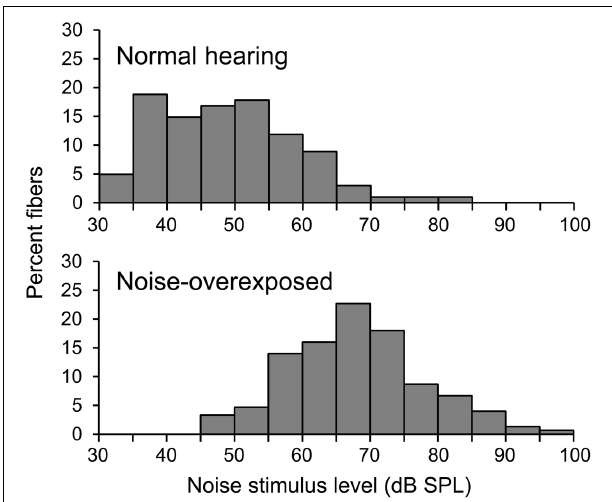
FIGURE 2 | Noise stimulus level. Histograms showing the distribution of noise stimulus levels presented to normal-hearing and noise-overexposed